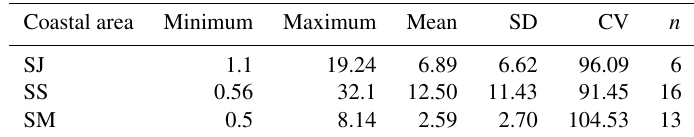
Table 1. Summary statistics of TSS values collected at the SJ, SS, and SM areas located within coastal regions in this study, with a total of 35 datasets recorded.